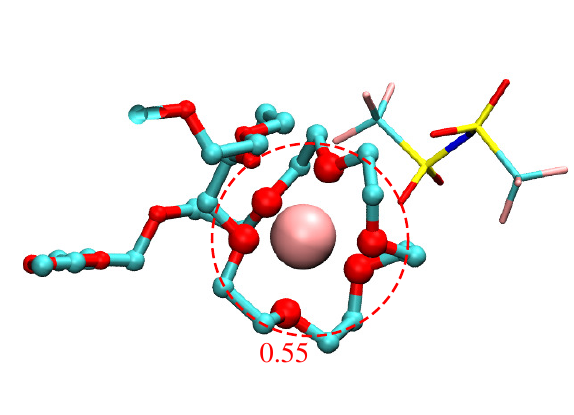
Figure 5. The schematics of 1 LiTFSI molecule and 1 PEO polymer chain (DP = 16). PEO polymer is illustrated using ball-and-stick representation, TFSI − molecule is presented via stick model, and the pink sphere represents a lithium ion. The Li + coordinating oxygen atoms of PEO are emphasized with larger size for their partial charges reduced by 0.55. The atom color codes are: oxygen in red, carbon in turquoise, nitrogen in blue, sulfur in yellow and fluoride in